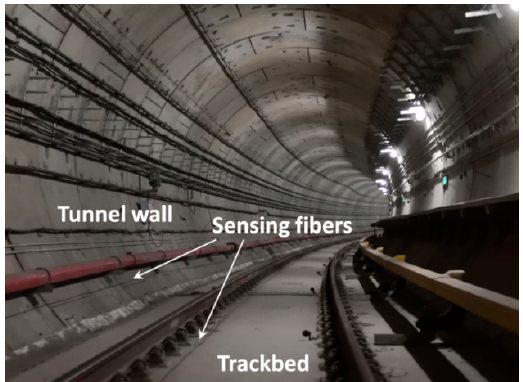
Figure 3. Distributed vibration sensing fibers mounted on the surfaces of the tunnel wall and the track